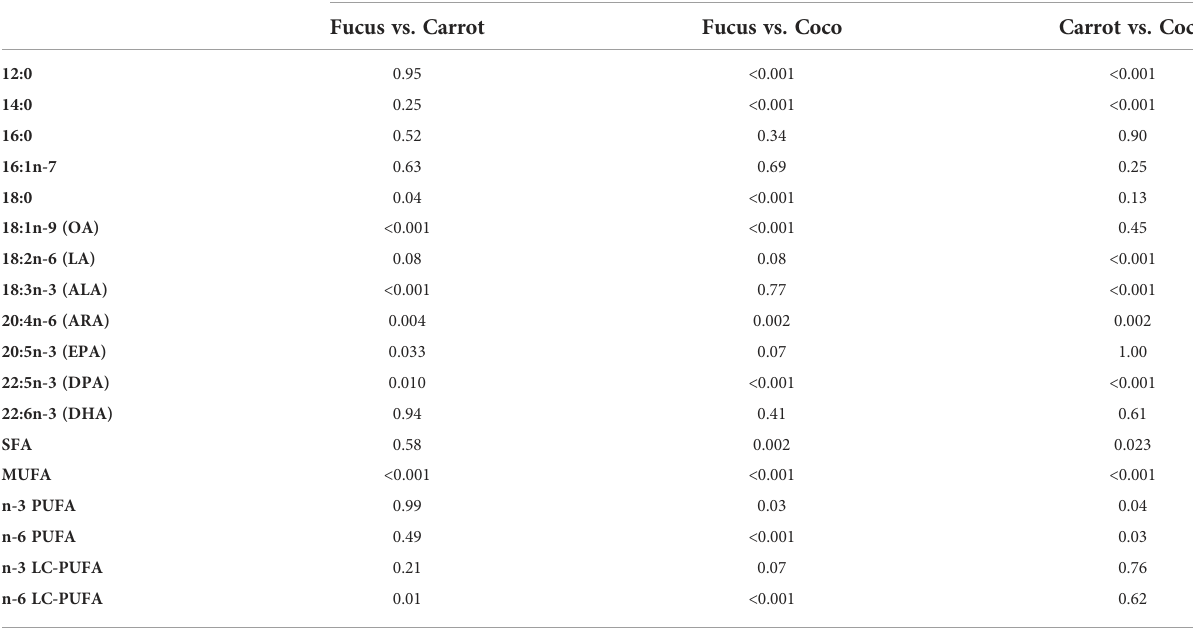
TABLE 5 Tukey ’ s post-hoc test after ANOVA of the fatty acid composition of G. locusta fed different diets. p- value Fucus vs. Carrot Fucus vs. Coco Carrot vs.